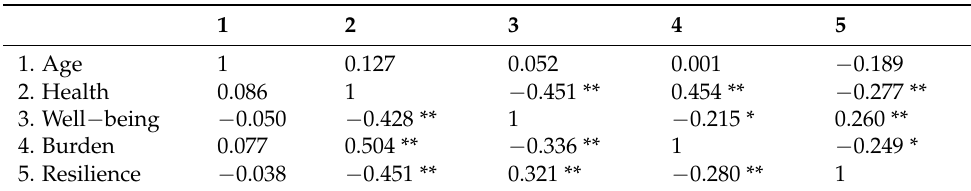
Table 3. Analysis of correlations between age, health, well-being, overload and resilience in pre-test (T1) and post-test (T2).